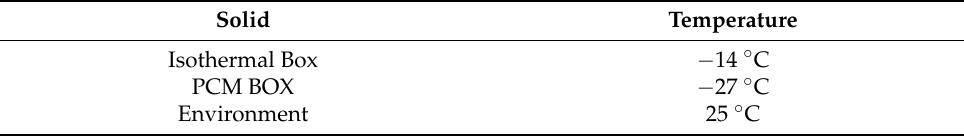
Table 3. Boundary conditions for the thermal